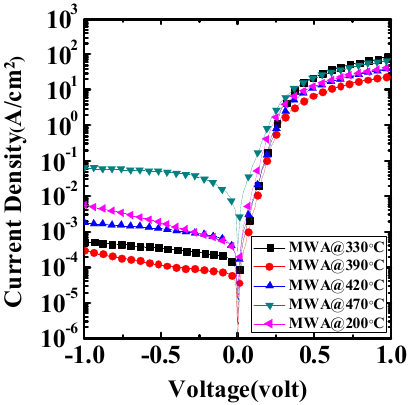
Figure 4. The I – V characteristics of the NiSiGe/n ‐ Si Schottky junction annealed at different MWA temperatures.